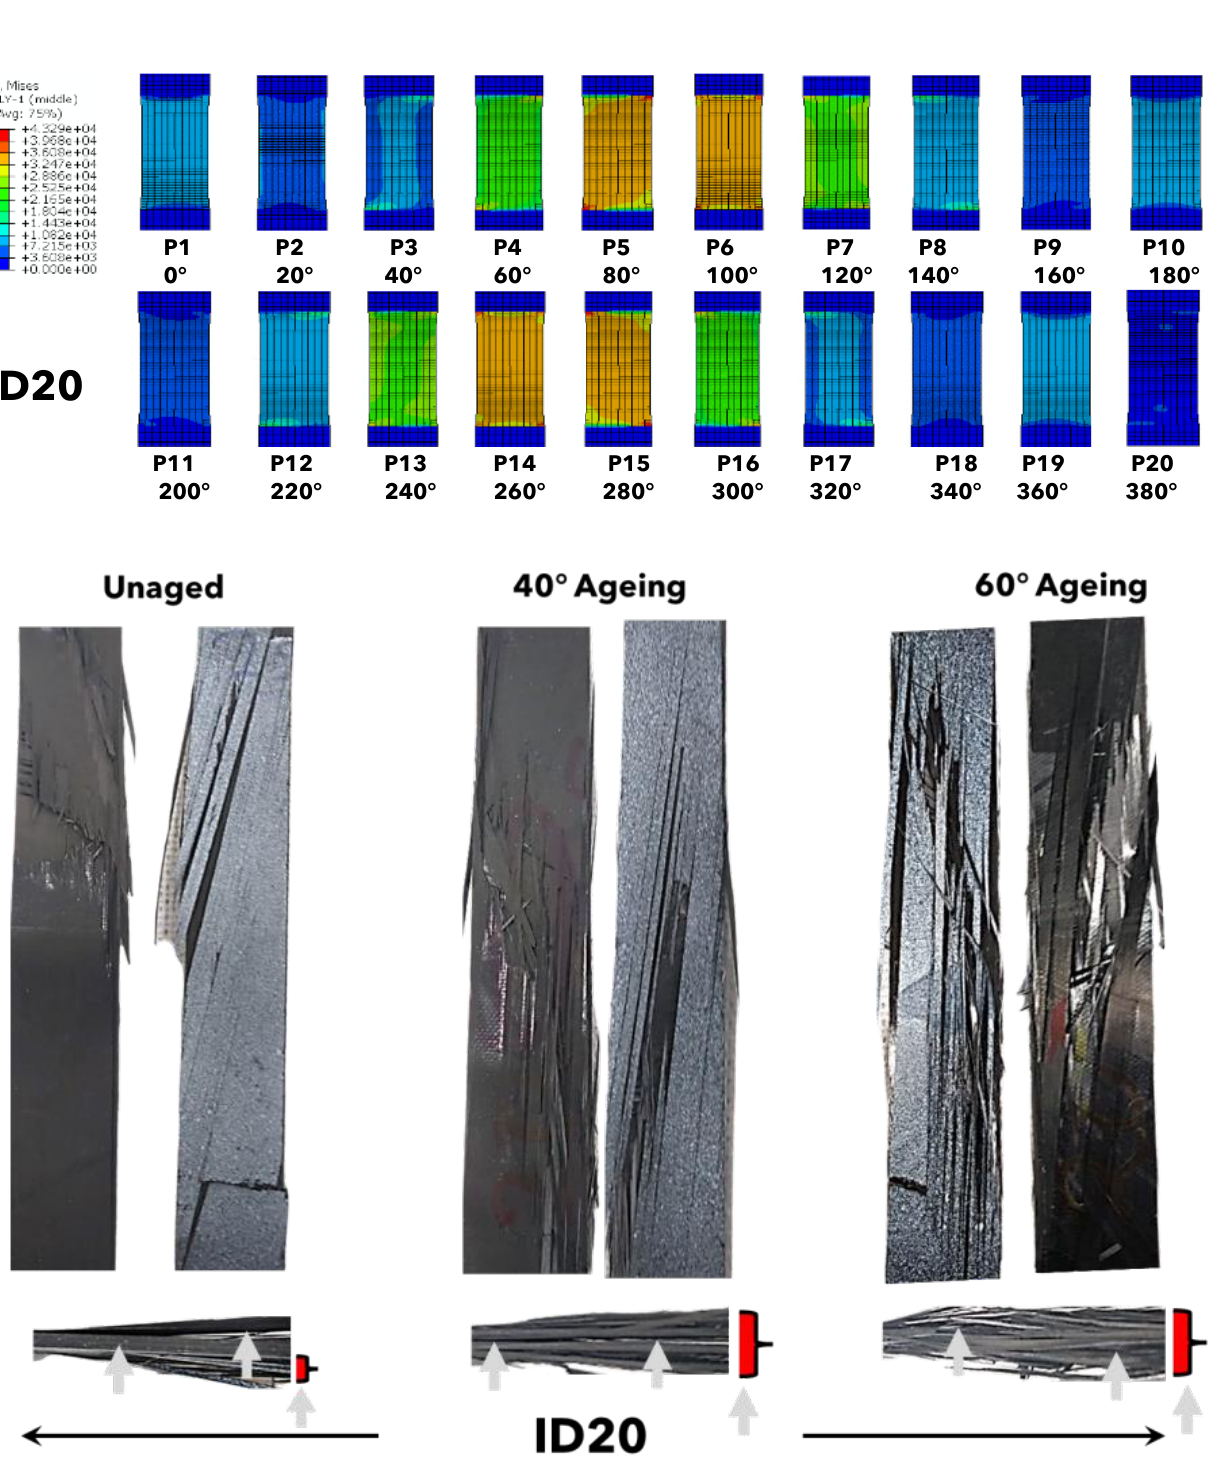
Figure 9. Stress (von Mises) distributions in individual dry plies predicted using the Hashin failure model, for ID20 composites ( top ), front and back face fractures from representative dry, 40 ◦ C, and 60 ◦ C aged samples ( middle ), and side view fractures from representative dry, 40 ◦ C, and 60 ◦ C aged samples ( bottom ), with arrows indicating the primary areas of fracture